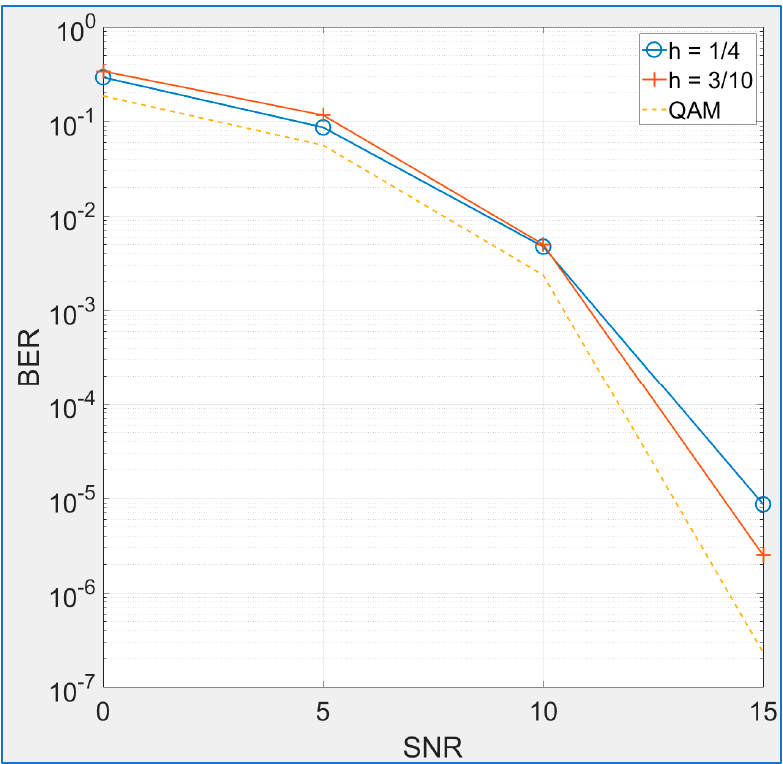
Figure 9 . BER performance of CPM-GFDM vs. QAM-GFDM with 𝐽 = 4 for zero forcing receiver Figure 9. BER performance of CPM-GFDM vs. QAM-GFDM with J = 4 for zero forcing receiver over AWGN channels. over AWGN channels.